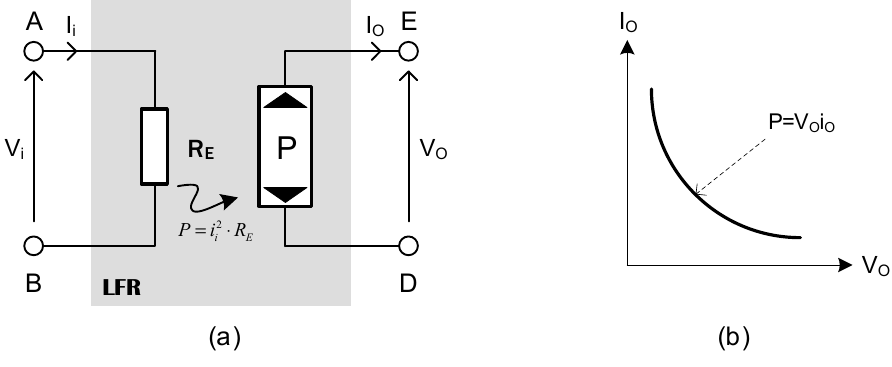
Figure 10. ( a ) The LFR model; ( b ) power source characteristic.